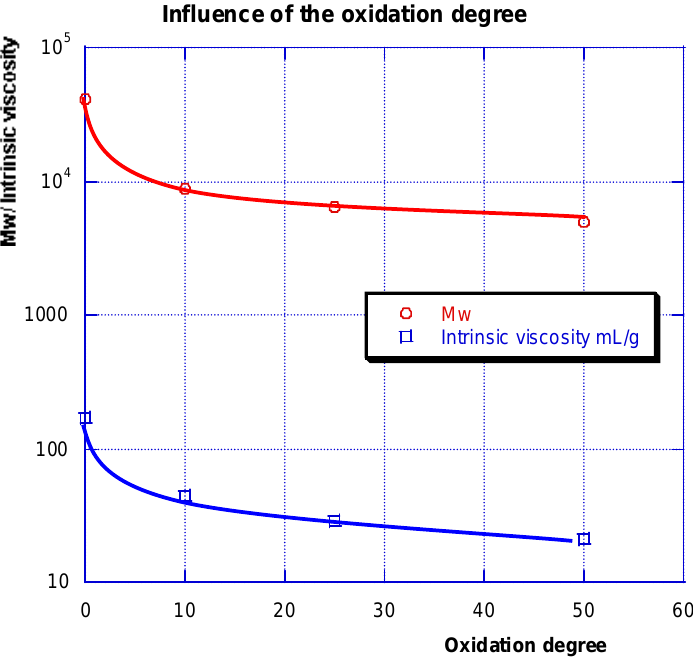
Figure 4. Influence of the degree of oxidation on the weight-average molecular weight (Mw) and on the intrinsic viscosity ([  ] in mL/g) obtained by SEC with a